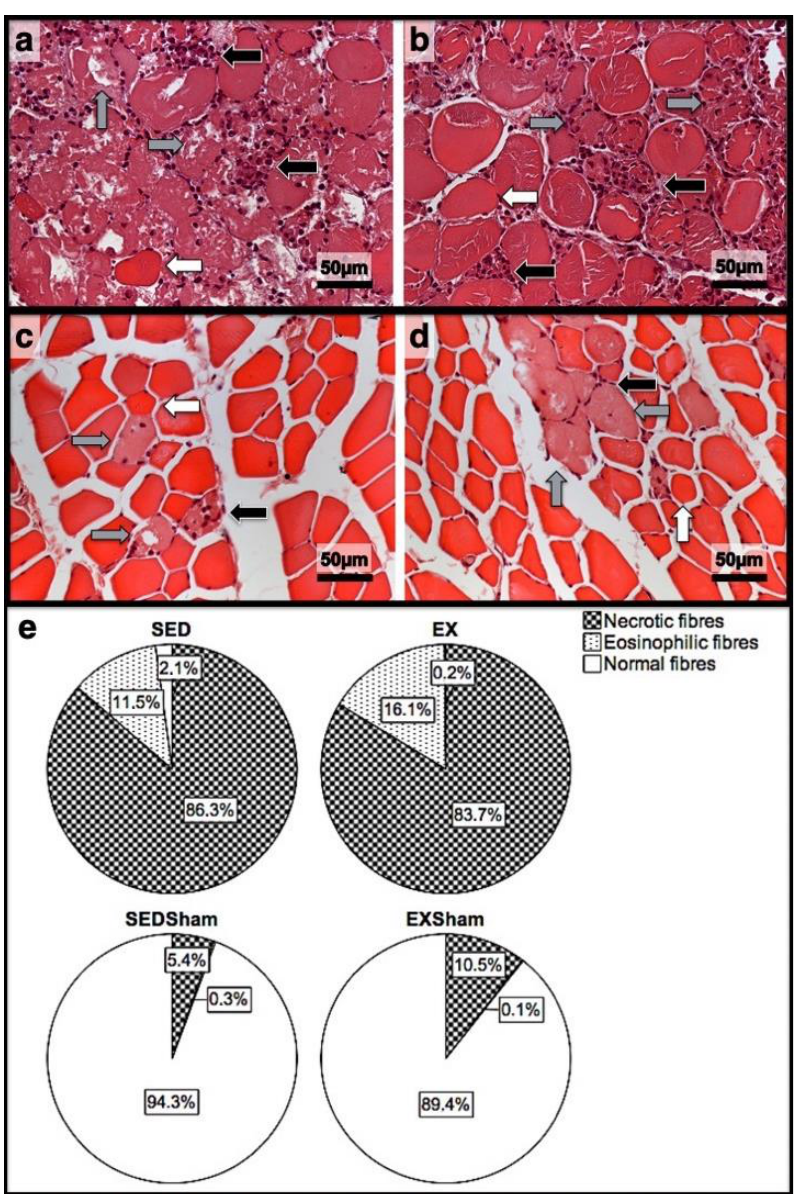
Figure 1. Representative images of the infused area of tibial anterior muscles stained with H&E from exercise (EX) and sedentary (SED) groups injected with cardiotoxin ( a , b ) and saline solution (Sham; ( c , d )) and sacrificed on the 1st day post-injection. In ( e ), the corresponding quantitative analyses of necrotic (fibres with fragmented and infiltrated sarcoplasm), eosinophilic (hypercontracted, enlarged, and rounded fibres with eosinophilic staining, i.e., bright-red sarcoplasm), and normal (fibres with peripheral nuclei, intact sarcolemma, and non-fragmented sarcoplasm) fibres is depicted. In ( a , b ), a vast inflammatory infiltrate (black arrows), the existence of several necrotic fibres (grey arrows), and the existence of eosinophilic fibres (white arrows) is clear. On ( c , d ), despite the presence of some necrotic fibres (grey arrows), inflammatory infiltrate (black arrows), and fewer eosinophilic fibres (white arrows), the majority are normal fibres. EX — exercise group injected with cardiotoxin; SED — sedentary group injected with cardiotoxin; EXSham — exercise group injected with saline solution; SEDSham — sedentary group injected with saline solution.